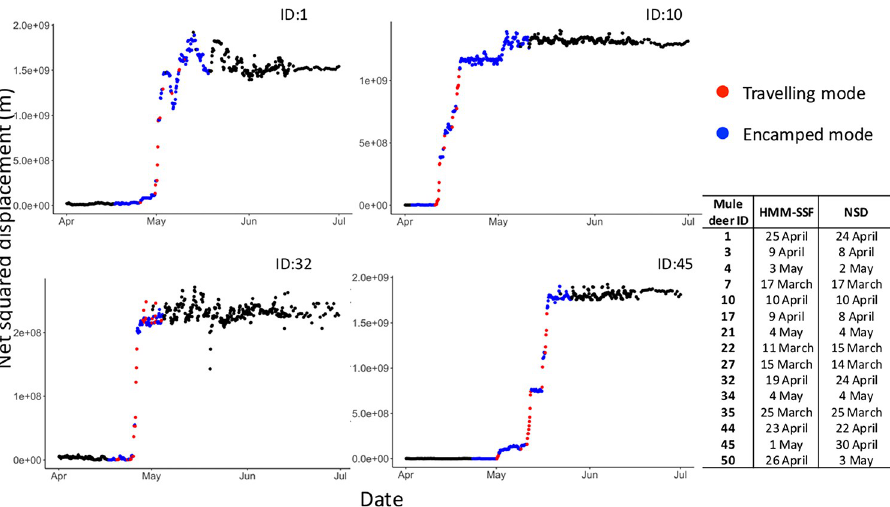
Fig 3. Net squared displacement over time for 4 mule deer geolocalised every 3 hours between April and July 2012 in Medicine National Bow Forest (WY-CO, USA). Net squared displacement is measured as the square of the Euclidean distance between location at a specific time t and start location (i.e., at time 1). Estimated mode of movement (red for travelling and blue for encamped) during the 2012 migration was based on the conditional probabilities of being in encamped and travelling mode at each step, as estimated from the HMM-SSF, and dichotomized to 0–1 using a 0.50 threshold.